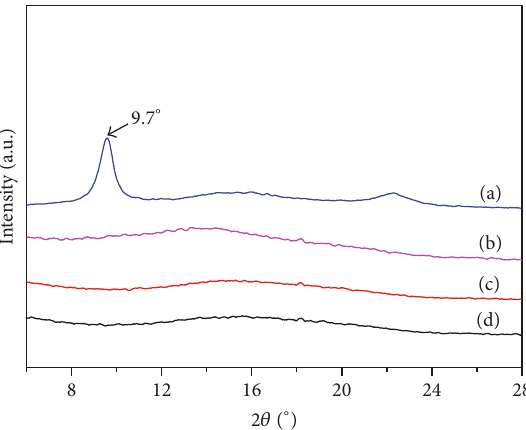
Figure 3: XRD patterns of GO (a), PNIPAM/KGM/GO1 (b), PNIPAM/KGM/GO2 (c), and PNIPAM/KGM/GO3 (d) composite